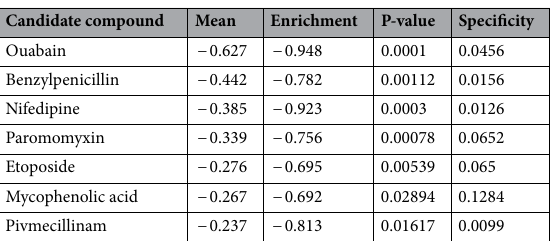
Fig. S2). Conversely, the topoisomerase II alpha (TOP2A) inhibitor VP16 exerted stronger antitumor effects on PC3CR cells than on PC3 cells (P < 0.001, Fig. 1B). Our another CBZ-resistant cell line, DU145CR derived from DU145 3 also had higher sensitivity for VP16 than parental DU145 cells (Supplementary Fig. S3). Because VP16 has been used to treat neuroendocrine prostate cancer (NEPC), we evaluated neuroendocrine markers in prostate cancer cell lines. As previously reported 16 , NCIH660 (a NEPC model cell line) tumors expressed neu-